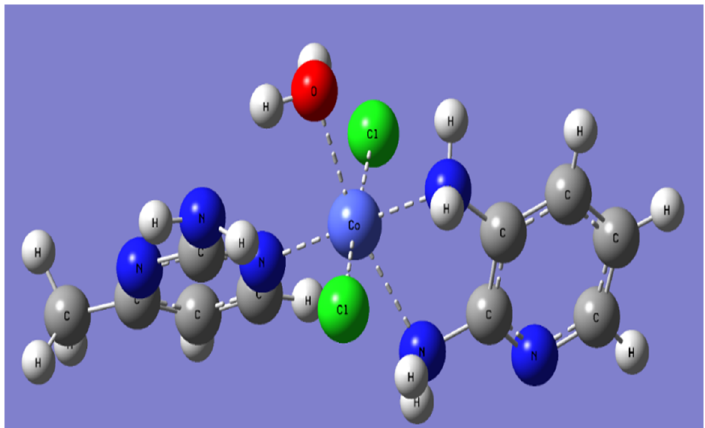
Figure 4. A perspective view of the complete coordination around Co(II) complex.